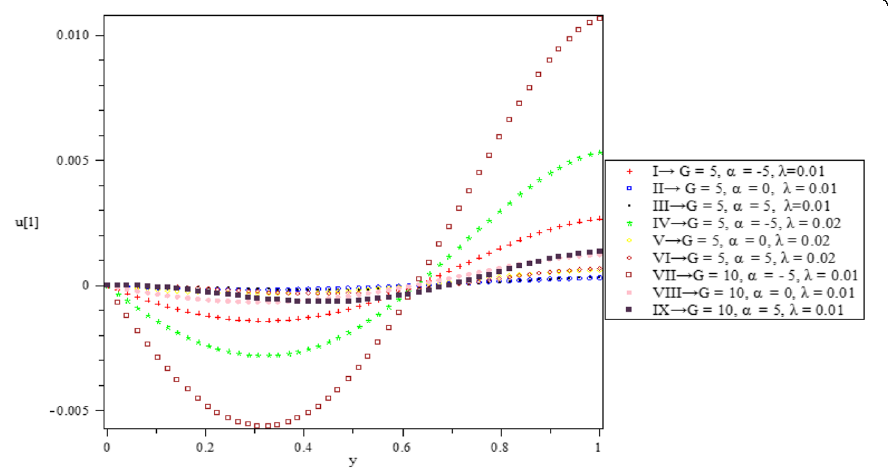
Fig. 14 First-order velocity (u[1] profile, r = − 1, ϵ = 0.25, P = 7, and β =